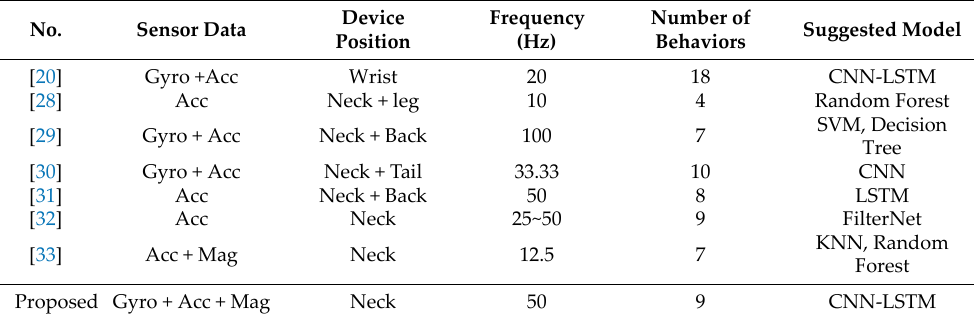
Table 1. Comparison of research on behavioral recognition based on sensor data.